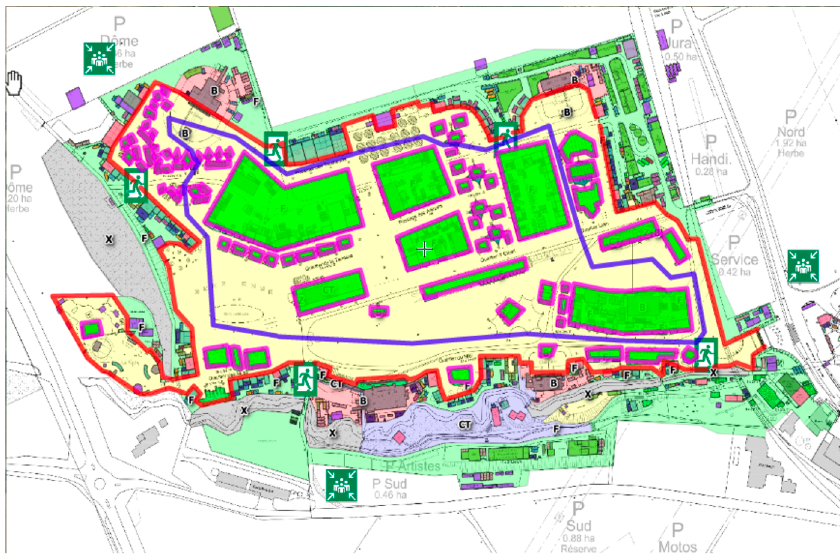
Figure 6. A picture from the manual annotation operation.